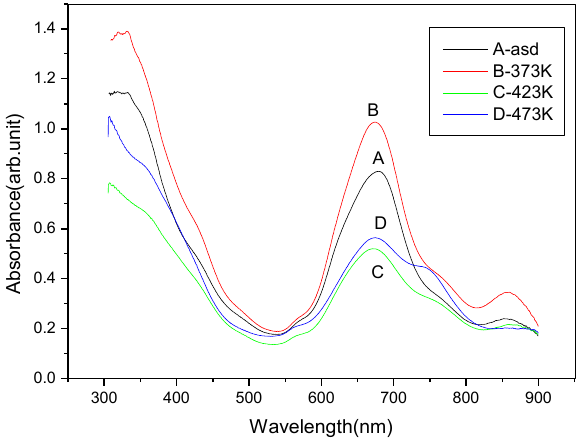
Figure 2. Optical absorption spectra of Cl FePc thin films of as-deposited form and 16 annealed at 373,423 and 473K in